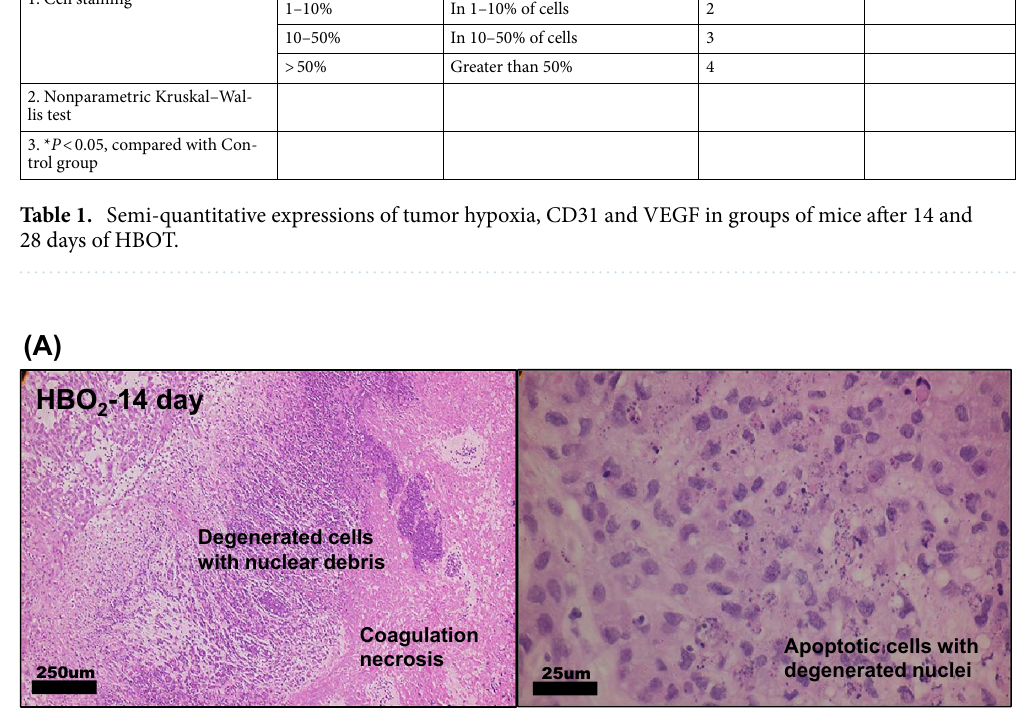
Figure 3. Immunohistochemistry staining of tumor sections from A549- transferred SCID mice. ( A ) Tumor paraffin sections of HBO 2 -14th date showed zonal inflammatory cells and degenerated cells aggregation in the border of coagulation necrosis. Immunostaining of cleaved-caspase-3 after 14 days of HBOT in HBO 2 group ( B ) and control group ( C ). Note that, in HBOT group, many cleaved-caspase-3 positive apoptotic cells were located in the border between coagulation necrosis and viable tumor cells. Comparative analysis of necrotic field ( D ) and cleaved-caspase-3 ( E ) was quantified from groups of mice. Statistical significance (* P < 0.05, compared with control group) was observed in HBOT group. H-score was defined by immuno intensity multiply by staining percentage (range from 0 to 300). Computer counting software of CellQuant and PatternQuant were used (3DHISTECH, Budapest, Hungary) for